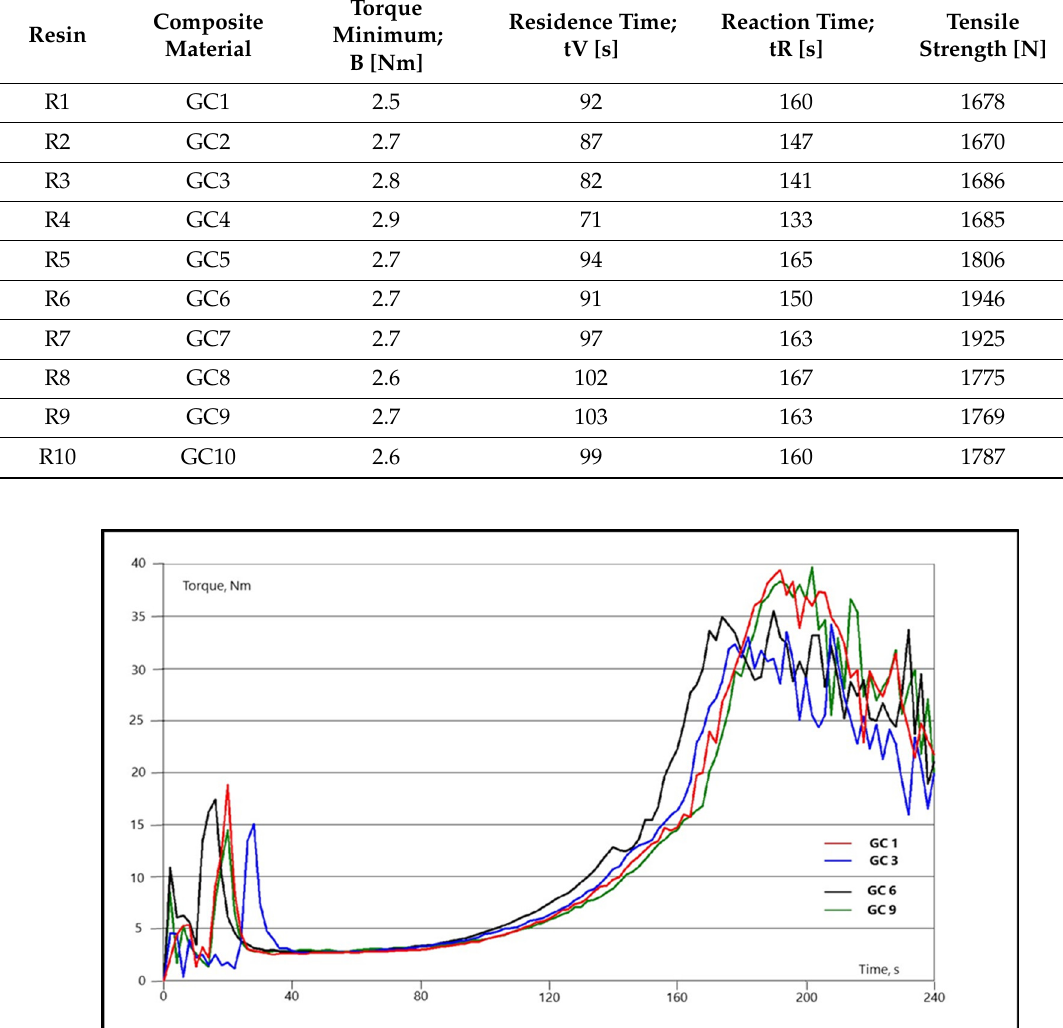
Table 2. Flow-curing behavior properties and mechanical properties of GC material and hot-pressed cylindrical test samples.